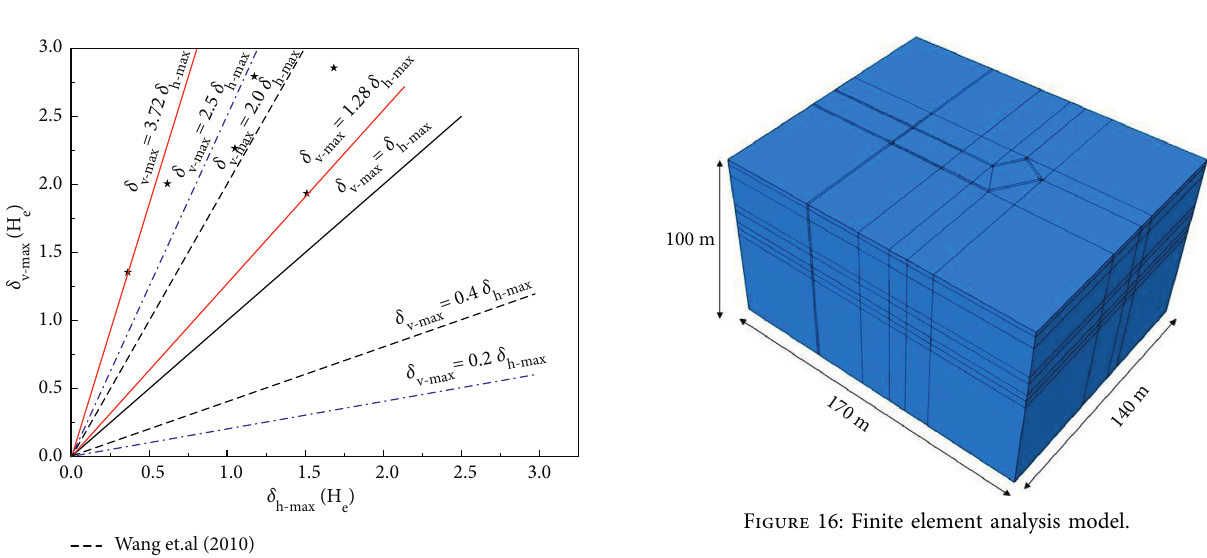
Figure 14: Relationship between the ground surface settlement and lateral wall displacement during excavation.